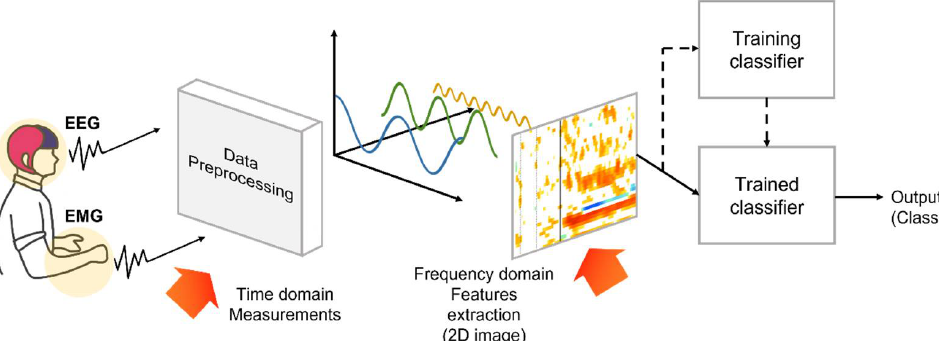
Figure 3. Schematic of algorithm flow starting from data acquisition and continuing to motion clas-